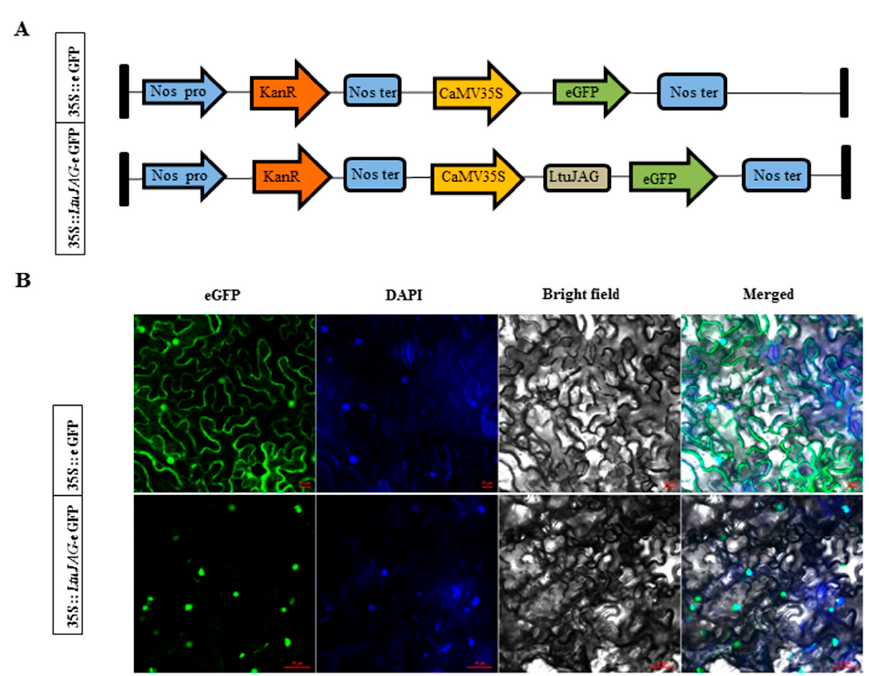
Figure 3. Subcellular localization of LtuJAG protein. ( A ) The construct of 35S::LtuJAG-eGFP and 35S::eGFP (eGFP: green fluorescent protein; NOS: nopaline synthase gene; KanR: Kanamycin resis- tance gene); ( B ) Subcellular localization of the 35S::LtuJAG-eGFP protein in tobacco epidermal cells. At 2 days after transfection, eGFP and DAPI (4 ′ ,6 ′ -diamidino-2-phenylindole, and nucleus specific dye) signal was observed by confocal fluorescence microscopy, 35S::eGFP was used as a control. Scale bars = 20 and 50 µm.